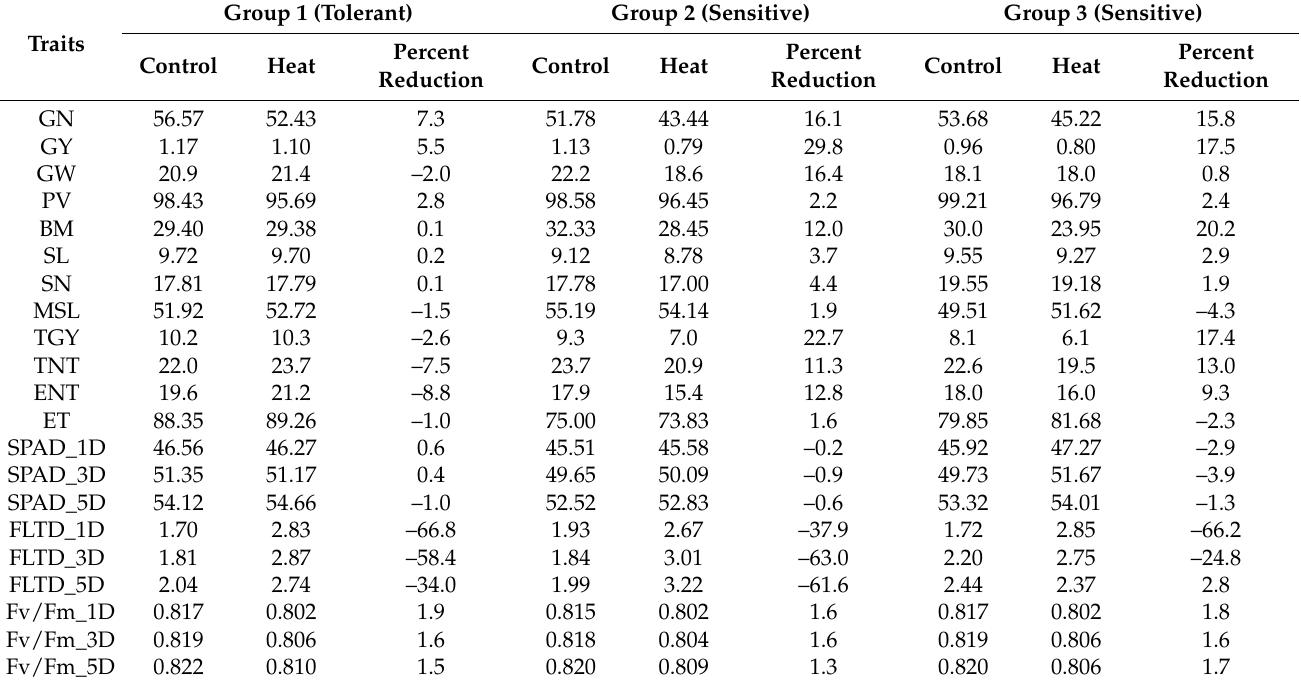
Table 2. Trait mean values for several yield-related and physiological traits in three groups of wheat cultivars based on PCA-based clustering for heat tolerance and sensitivity at meiosis. Percent reduction in traits is the relative value of the mean in the high temperature treatment (“Heat”) and the mean in the control temperature treatment (“Control”), and positive values indicate that the high temperature means are lower than the control means. The separation of cultivars into three groups based on their heat tolerance and sensitivity is shown in Figure